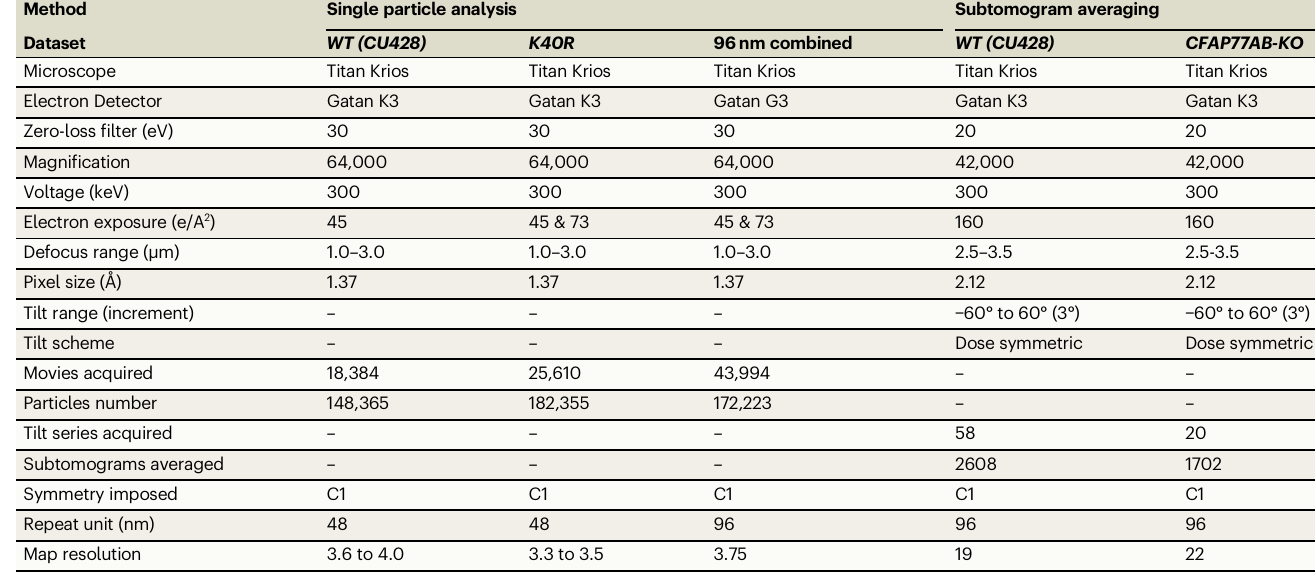
Table 1 | Cryo-EM data collection and re fi nement parameters for all datasets used in this